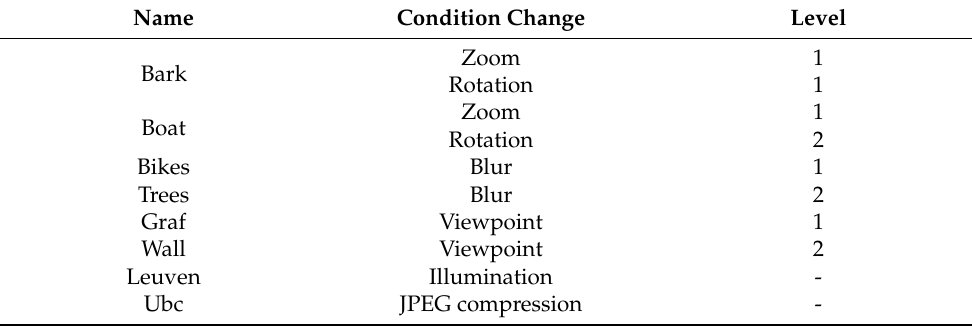
Table 1. Oxford dataset result presentation